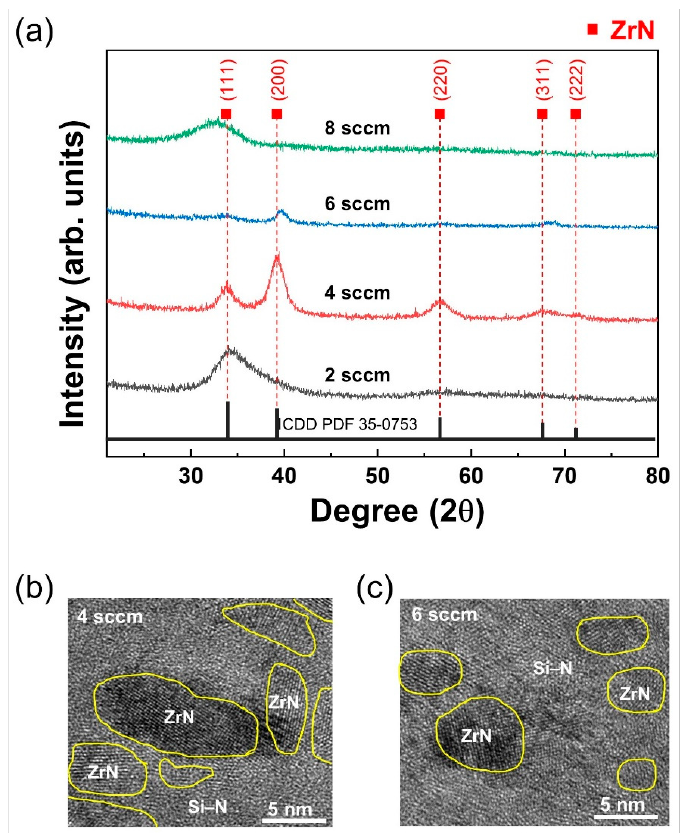
Figure 3. ( a ) XRD patterns of the ZrCuSiN coatings deposited at different N 2 gas flow rates. ( b ), ( c ) TEM images of the ZrCuSiN coatings deposited at different nitrogen gas flows: ( b ) 4 sccm; ( c ) 6 sccm.